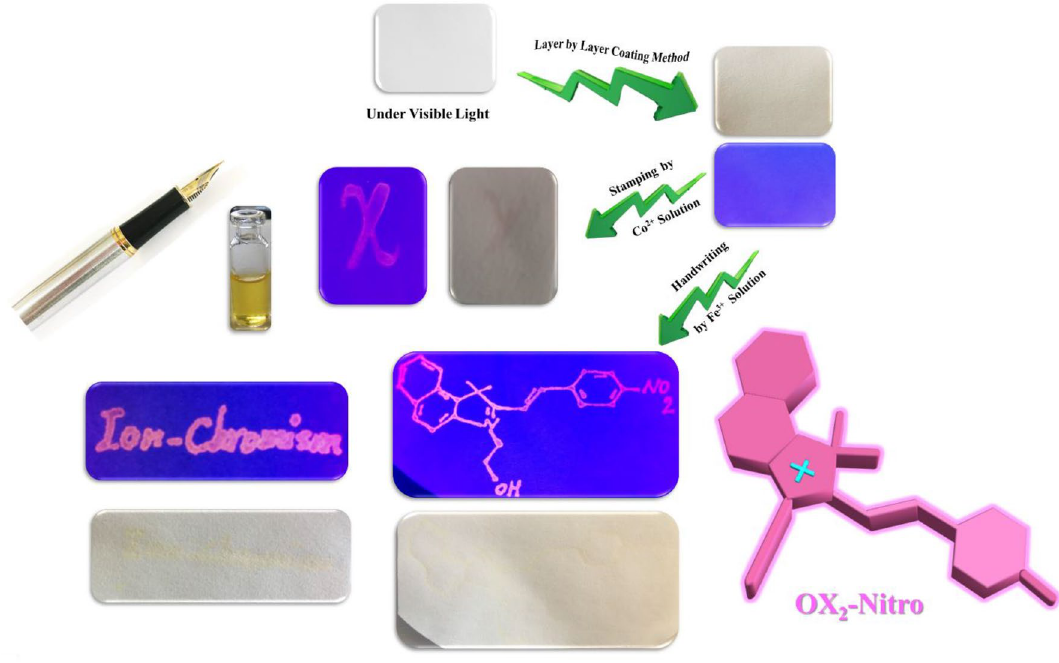
Figure 6. Handwriting and stamping of Fe 3+ and Co 2+ aqueous solutions on the ionochromic security papers coated with OX 2 -Nitro.